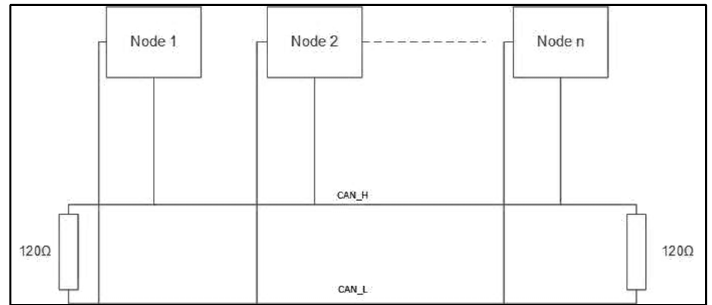
Figure 4. Typical CAN node configuration.